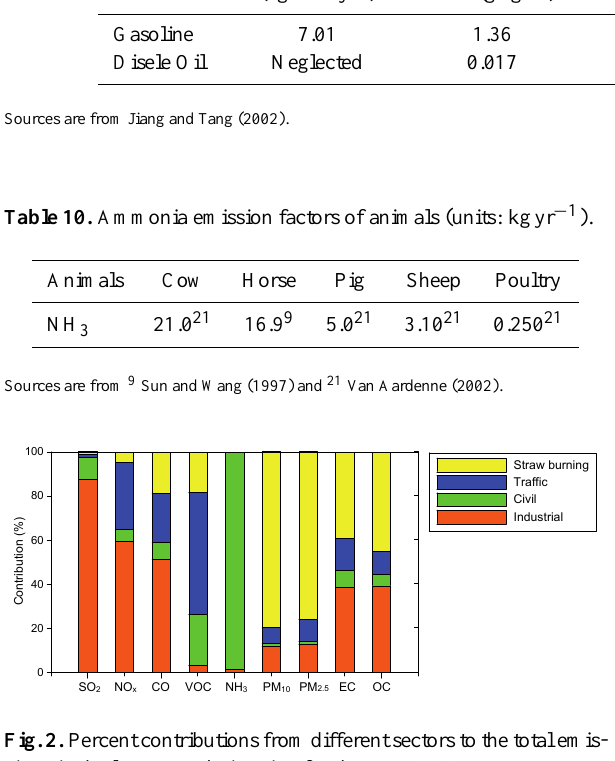
Table 9. VOC emission factors of oil depot. Type Breath Coefficient Working Gasoline Disele Oil Neglected Sources are from Jiang and Tang (2002).